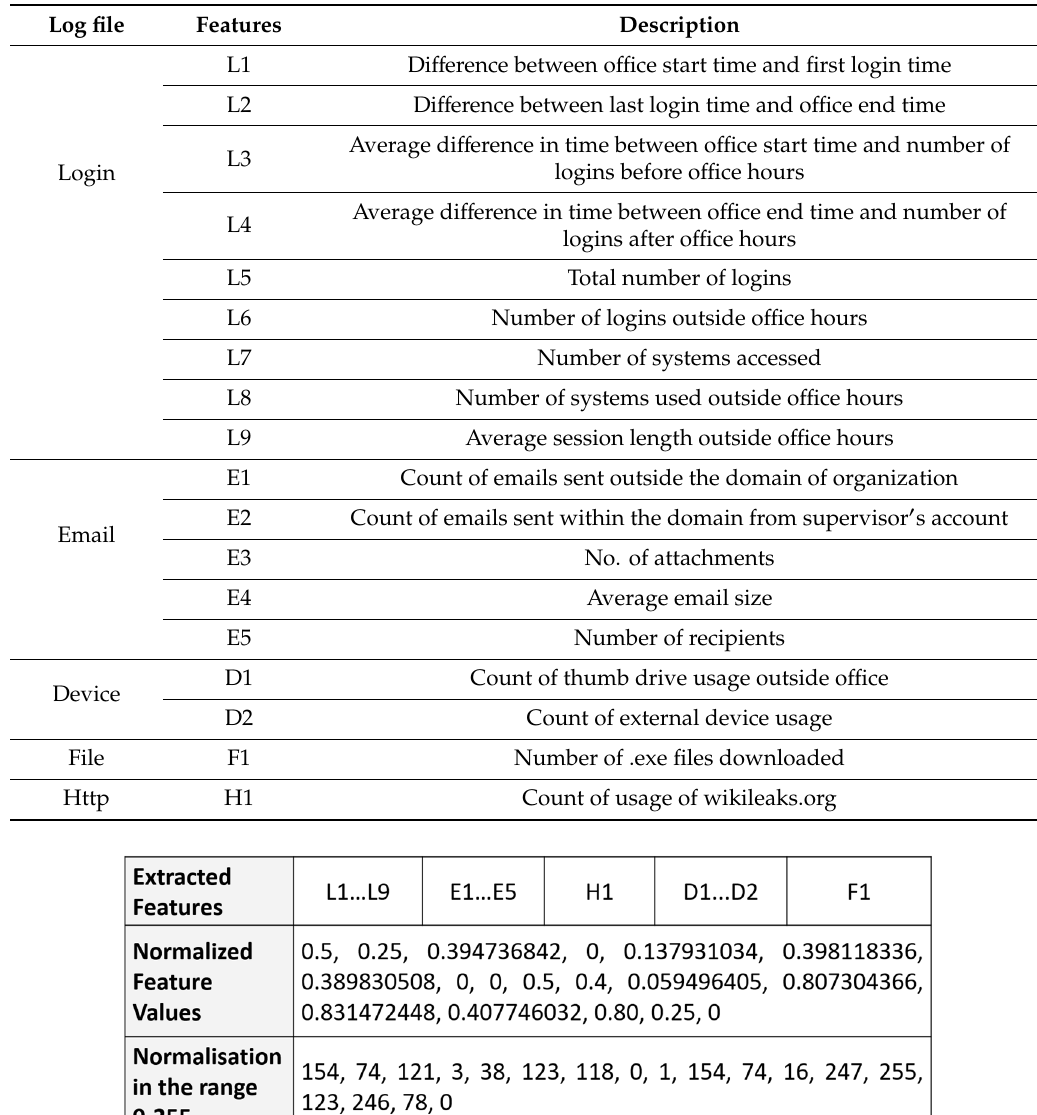
Table 1. Feature set used in the proposed approach.